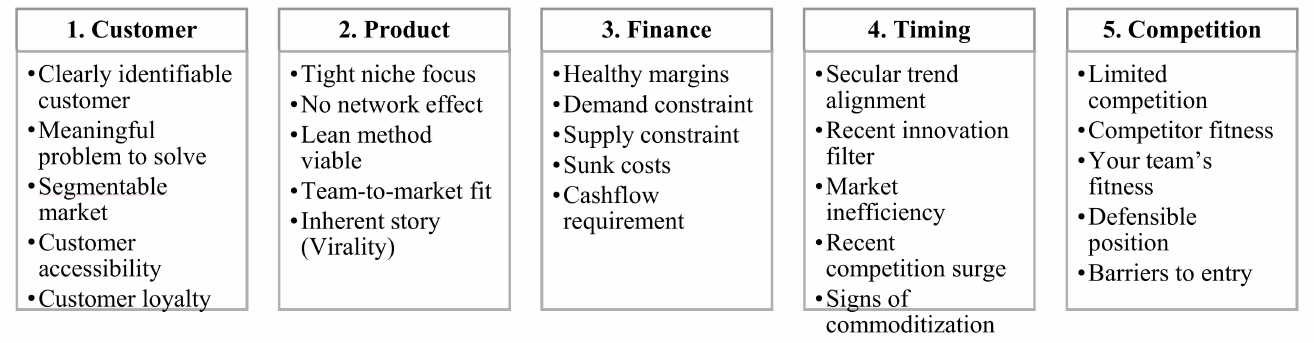
Figure 1. The POEM framework. After Cabage/Zhang 2013 [45].